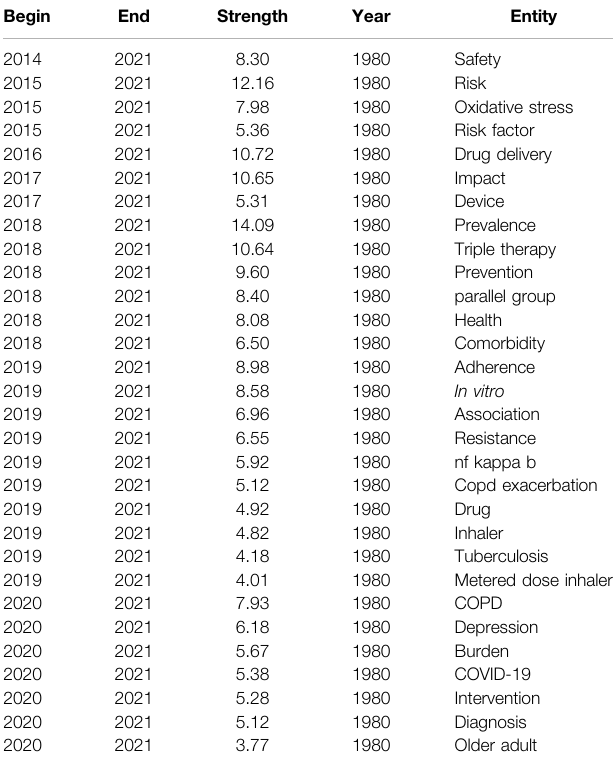
TABLE 8 | Keywords with the strongest citation bursts of COPD drugs-related studies from 1980 to 2021.